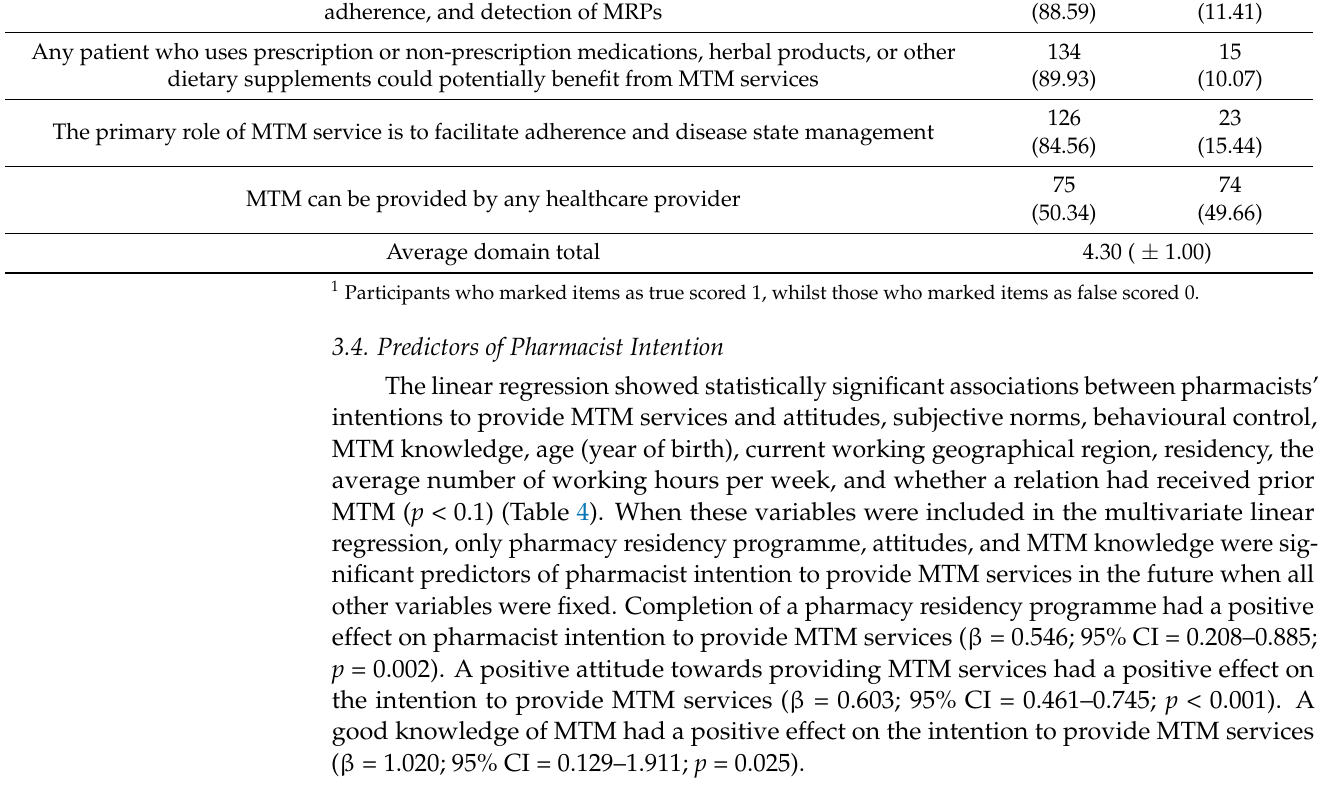
Table 4. Multivariate linear regression analysis of factors associated with average intention to provide MTM services ( n =